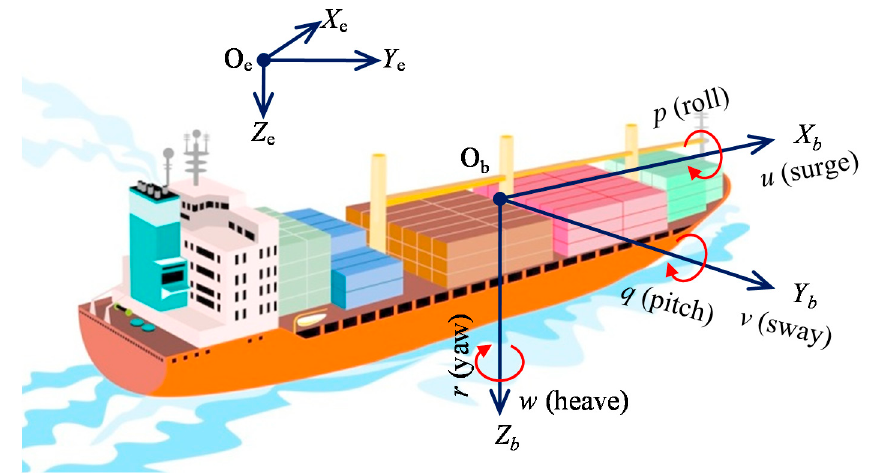
Figure 1. Ship’s body fixed and earth fixed coordinate frames.